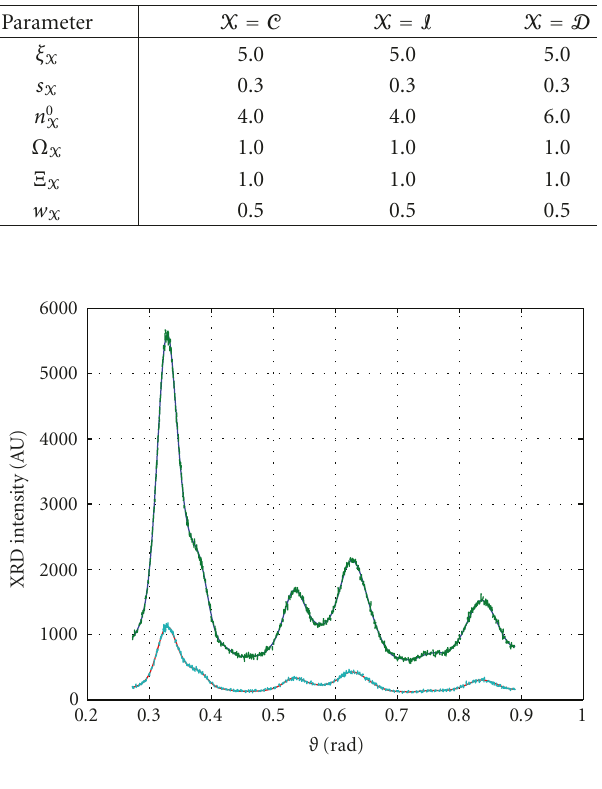
Figure 1: Synthetic XRD intensity profiles as a function of the scat- tering angle. From the upper to the lower profile, the NSR increases from 2% to 5% (see Figure 2 and text for